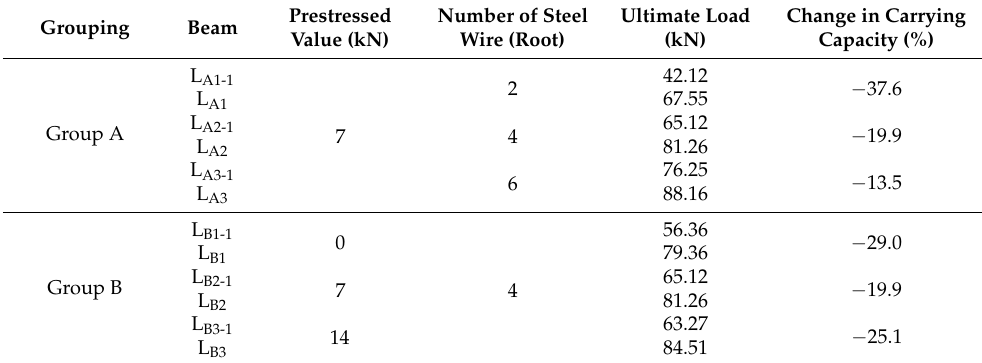
Table 3. The comparison information of ultimate load between long-term beam and short-term beam. Grouping